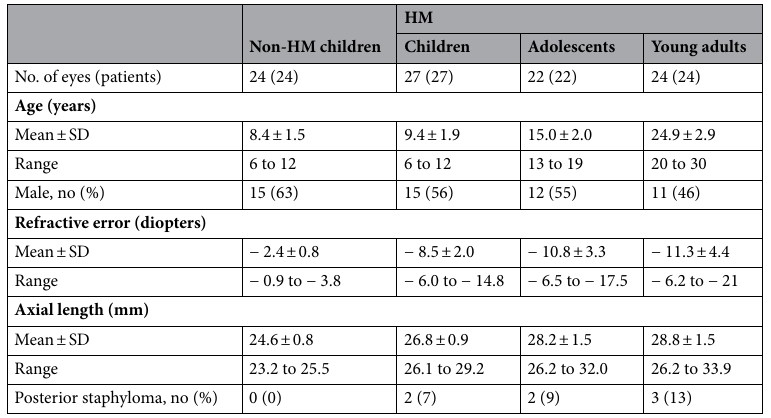
Table 1. Clinical characteristics of young patients with and without high myopia. HM high myopia, SD standard deviation.